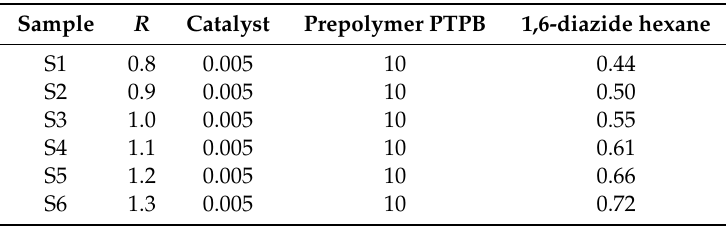
Table 1. PT ri PB elastomer components in